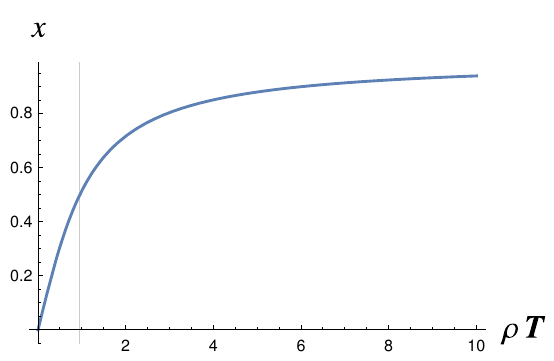
Figure 6 . The relation between the radial coordinate (cid:26) and the (cid:12)nite one x , which we use in the numerical simulation (A.4), c = 0 : 95 T (cid:0) 1